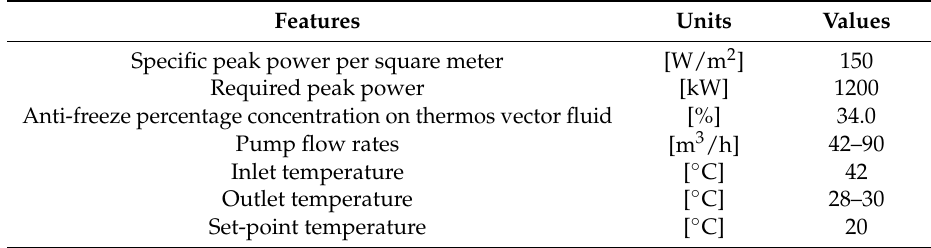
Table 3. Technical specifications of the football pitch’s heating system.